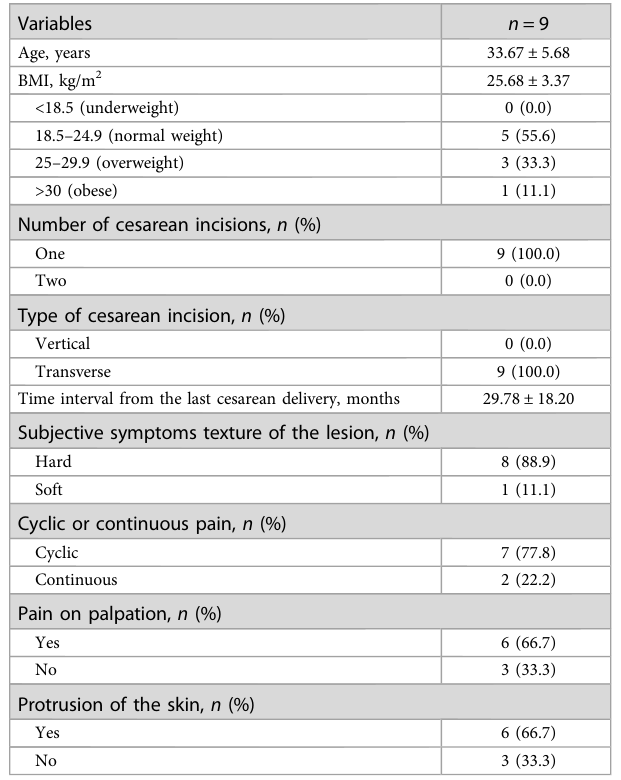
TABLE 1 Demographic characteristics of patients with